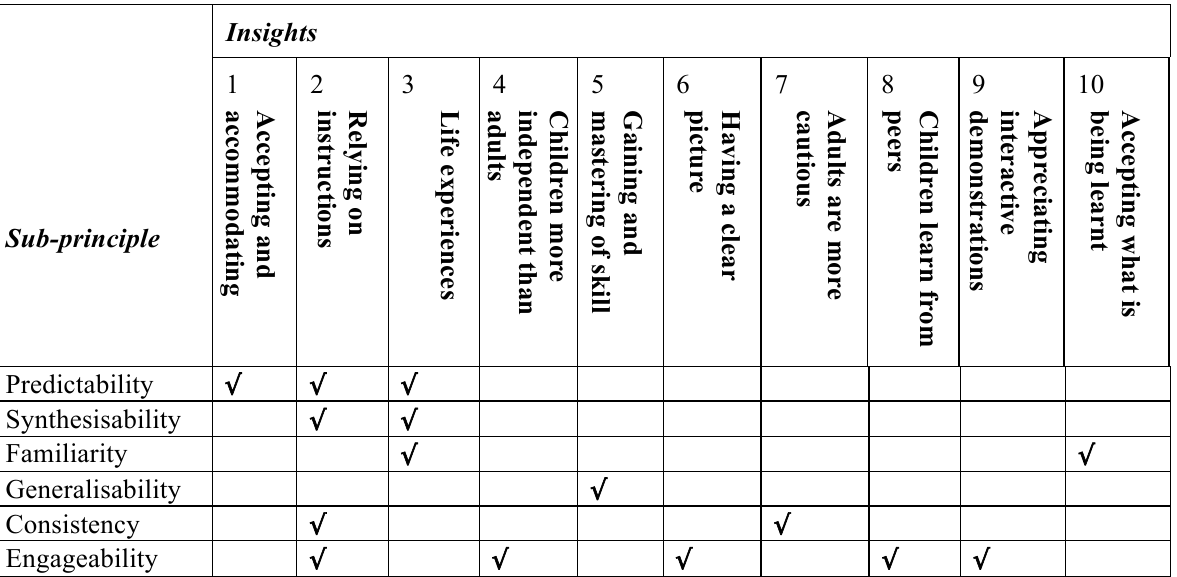
Table 2: Matrix of insights and sub - principle